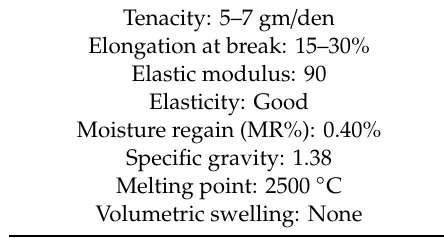
Table 2. Phytochemical properties of polyester.